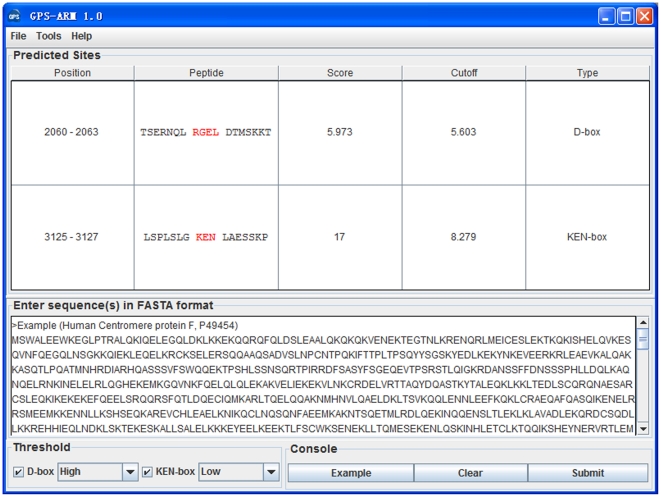
Screen snapshot of the GPS-ARM 1.0 software.The default thresholds were chosen for the D-box (high) and KEN-box (low). As an example, the prediction results for the human centromere protein F/CENP-F (UniProt ID: P49454) are shown.